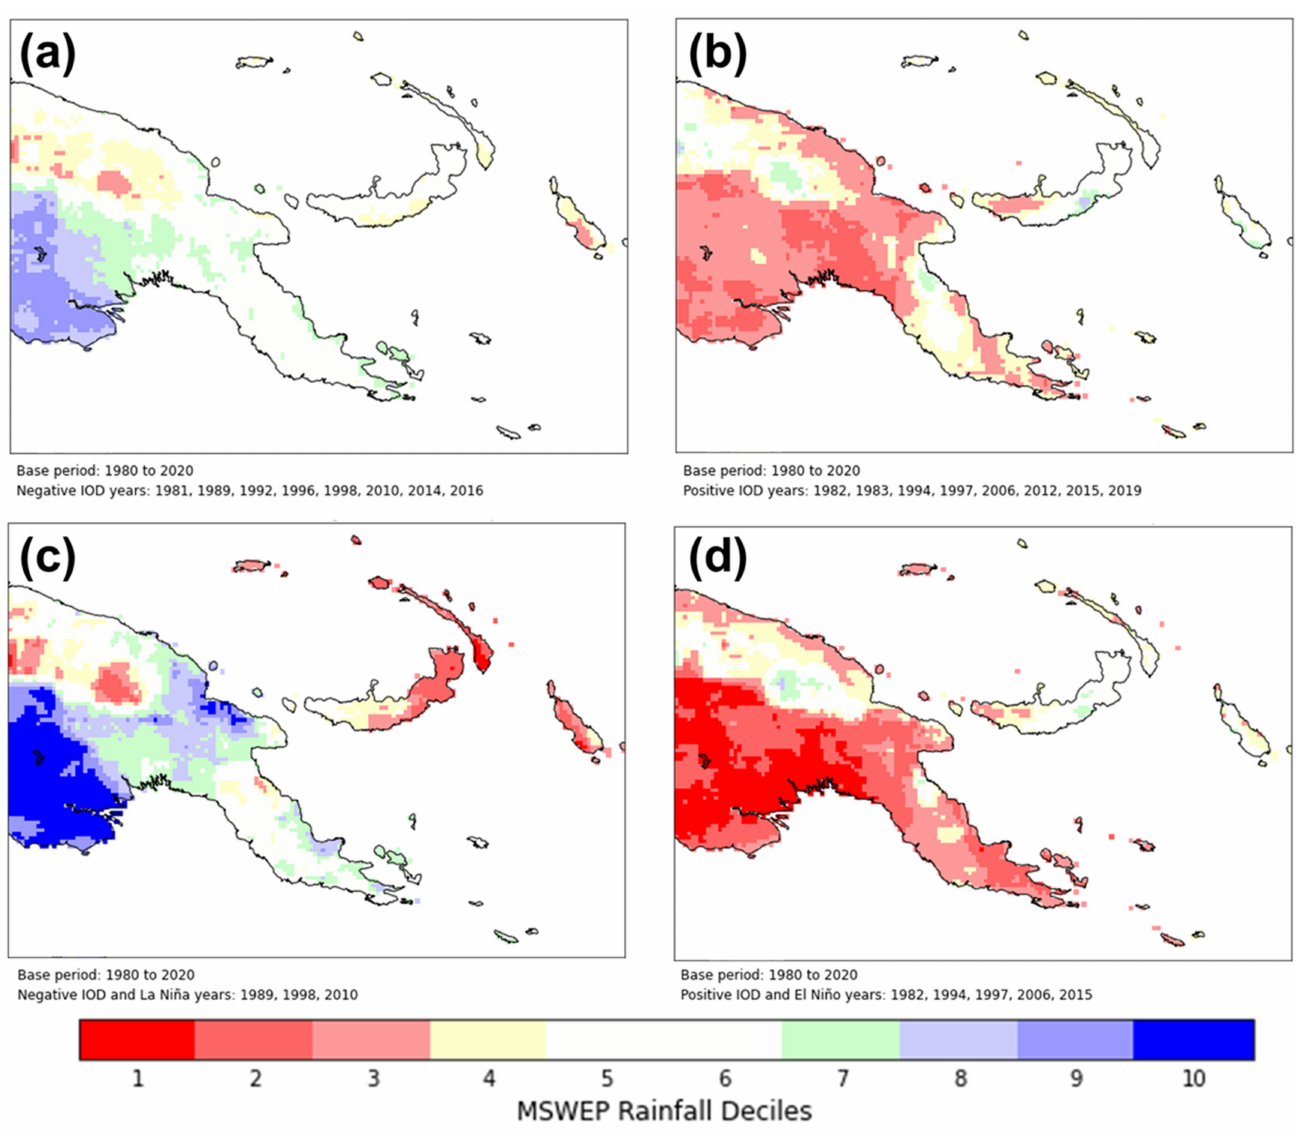
Figure 15. MSWEP rainfall deciles in ( a ) Negative IOD, ( b ) Positive IOD, ( c ) Negative IOD and La Niña and ( d ) Positive IOD and El Niño events compared to a base period of